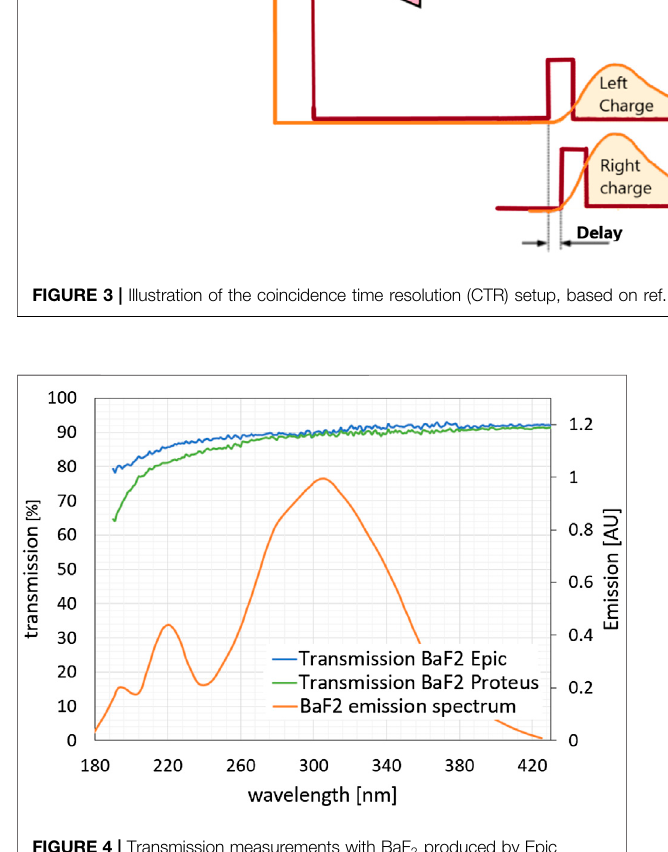
Frontiers in Physics |